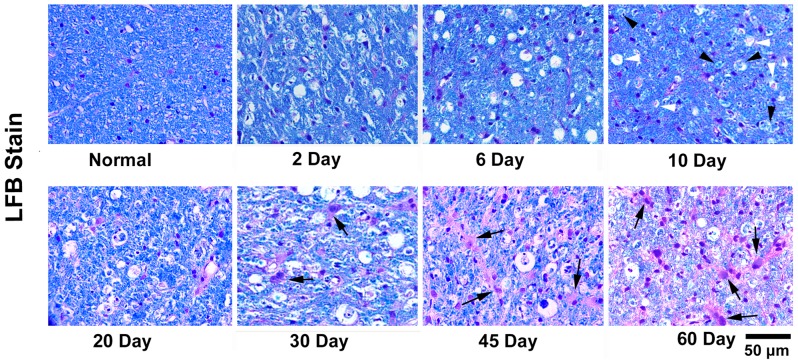
LFB stained histological images of cat's pons.The LFB images of normal and degenerated side of pons at 2nd, 6th, 10th, 20th, 30th, 45th and 60th day after modeling were displayed. White arrow heads indicated the activated microglias that phagocytized the axonal debris (purple stained), while black arrow heads labeled the microglias with myelin debris (blue stained). Black arrows indicated the reactive astrocytes. Scale bar, 50 µm.